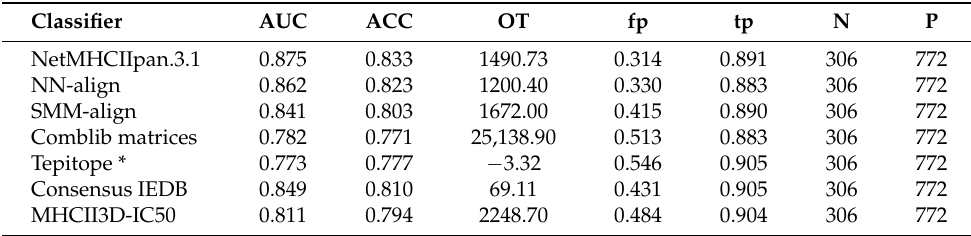
Table 2. Prediction accuracy (ACC) compared to other methods on a set of 1078 entries of the IEDB weekly benchmarks. Numbers are computed based on an optimal threshold (OT) utilizing the software tool StAR [35]. Besides the AUC and the accuracy, the false positive (fp), true positive (tp), the number of non-binders (N), and the number of binders (P) are shown. * In the case of Tepitope, the AUC value is inverted (1-AUC).